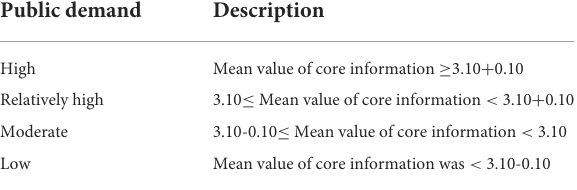
TABLE 2 The description of public demand for core